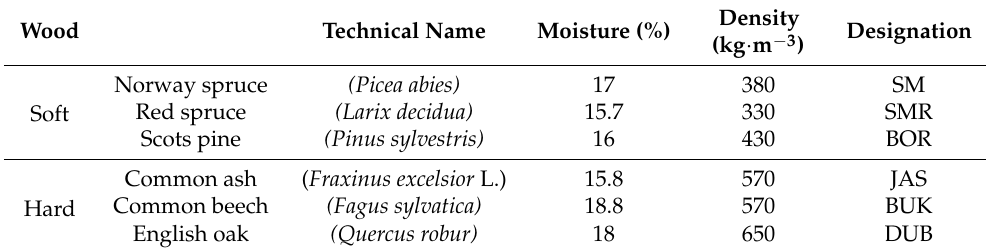
Table 1. Wood samples used in the experiment.